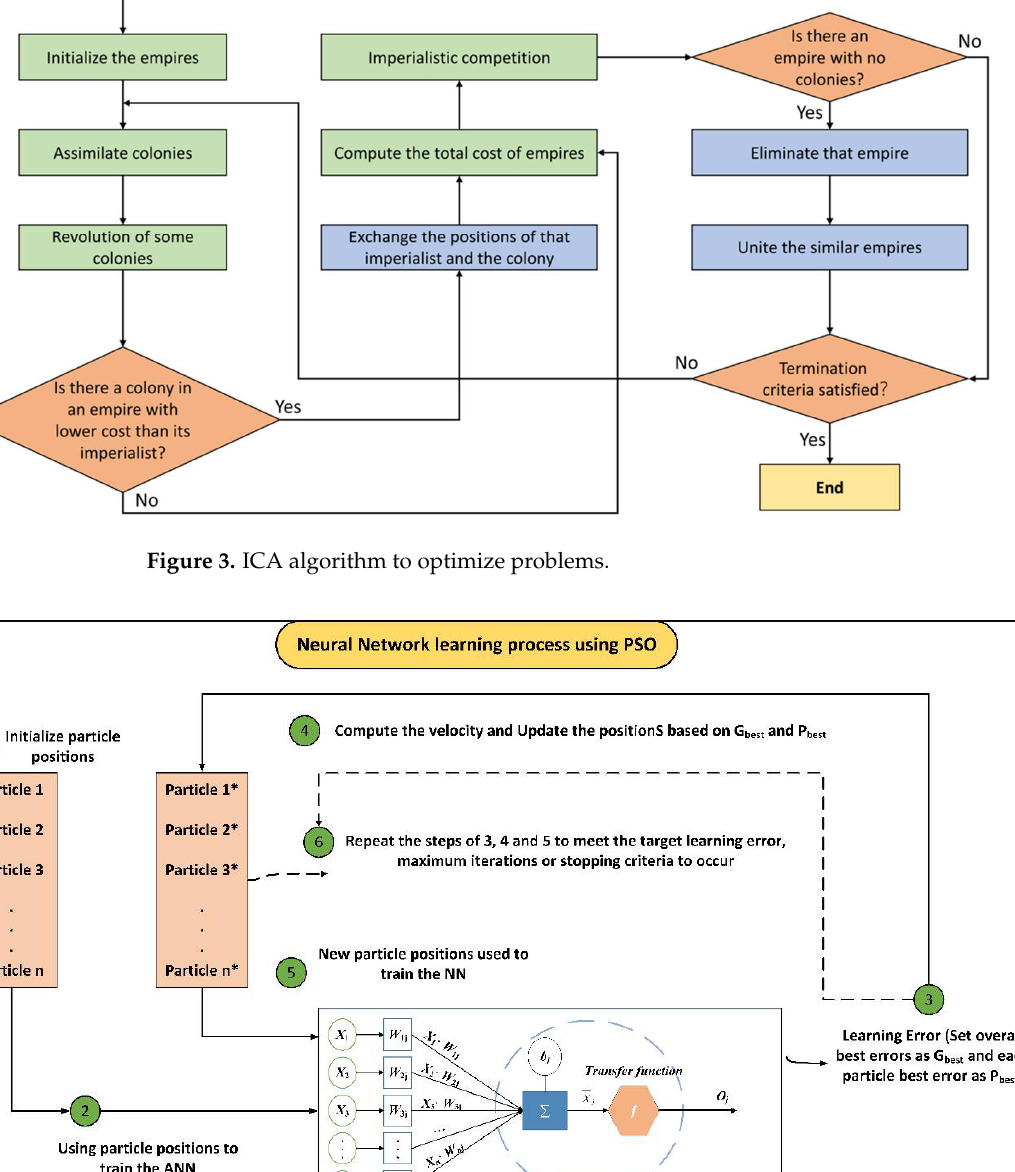
Figure 5. ICA-ANN algorithm. 3. Data Source and Input Parameters 3.1. Background For many years, types and shapes of columns have been developed from typical re- inforced concrete columns and steel columns into steel-reinforced concrete columns and various types of composite columns such as CFST columns, encased columns, and also